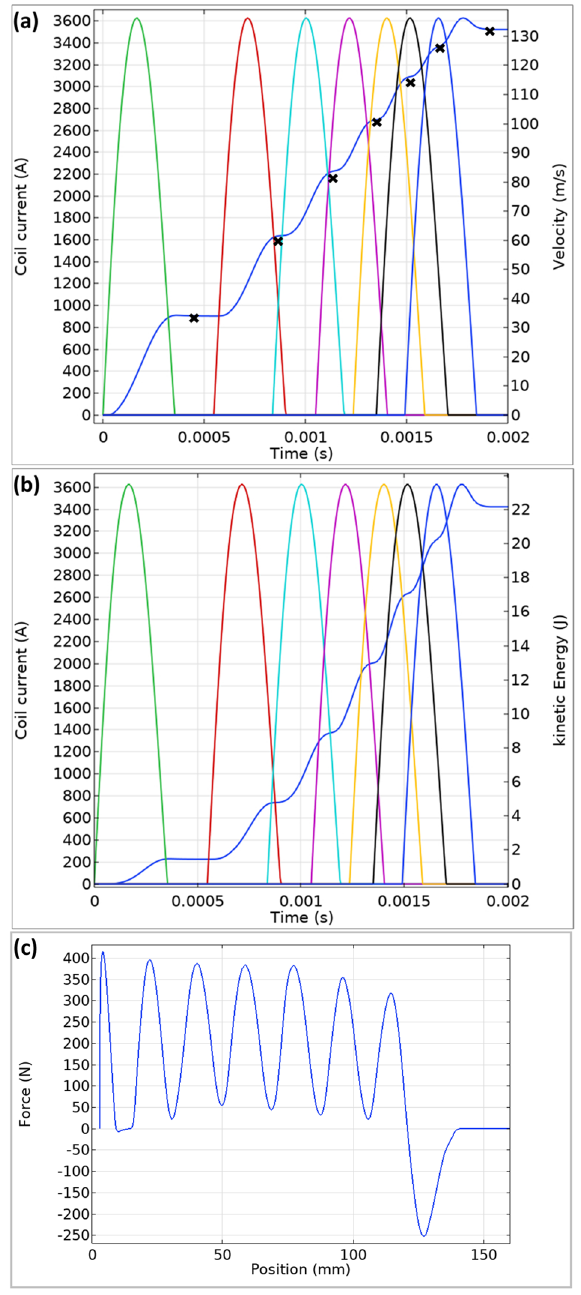
Figure 10. Simulation results of seven stage launcher, velocity ( a ) and energy ( b ) as a function of time, and force as a function of the position ( c ). The ’ x ’ marks represent the experimental measurements results.